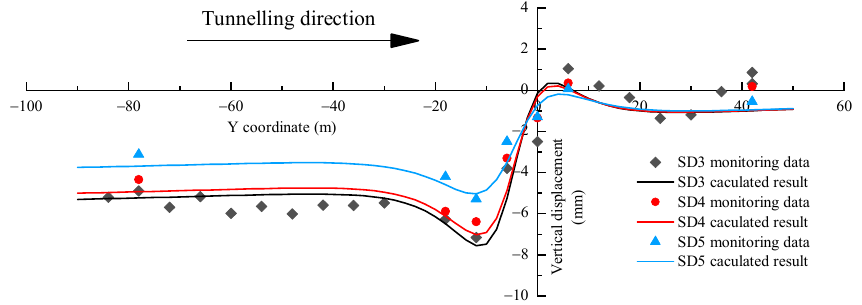
Figure 16. Comparison of predicted and measured longitudinal ground displacement in case B.